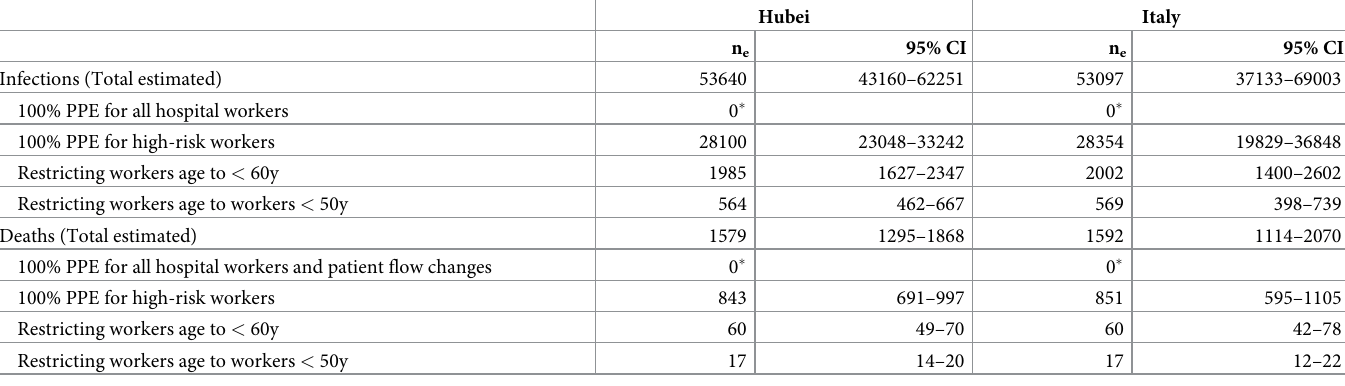
Table 4. Adjusted estimated infection and death counts among hospital workers in the